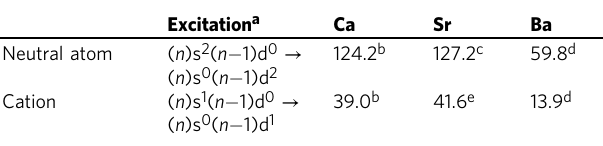
Values are given in kcalmol − 1 a The electronicground states are 1 S forthe neutral atoms M and 2 Sfor the ions M + . Thelowest lyingexcitedreferencestates ofthe neutralatomsare 3 F forCaand Baand 3 P forSr. Thelowest lying excited reference state of the cations M + is 2 D. The cited values refer to the lowest J level b ref.